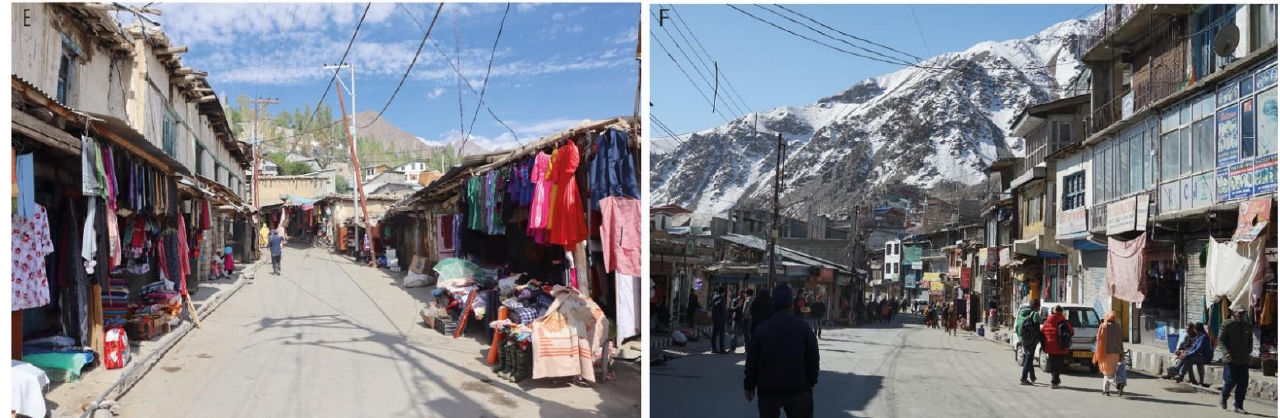
Figure 2. Photographs showing settlements of different areas in Kargil town. Top : Baroo and Baroo colony urban settlements along with cultivated fields at the upper part of Baroo on the opposite side of Suru River in August 2009 ( A ) and March 2023 ( B ). Middle : urban structure of Kargil town at the junction of Suru and Wakha rivers ( C ) and Andoo colony on steep slope area ( D ). Bottom : local bazaar of old town ( E ) and along National Highway-301 ( F ). Photos—( A ): Susanne Schmidt, August 2009, ( B ): Marcus Nüsser, March 2023; ( C – E ): Altaf Hussain, August and September 2021, 2022, ( F ): Susanne Schmidt, March 2023.